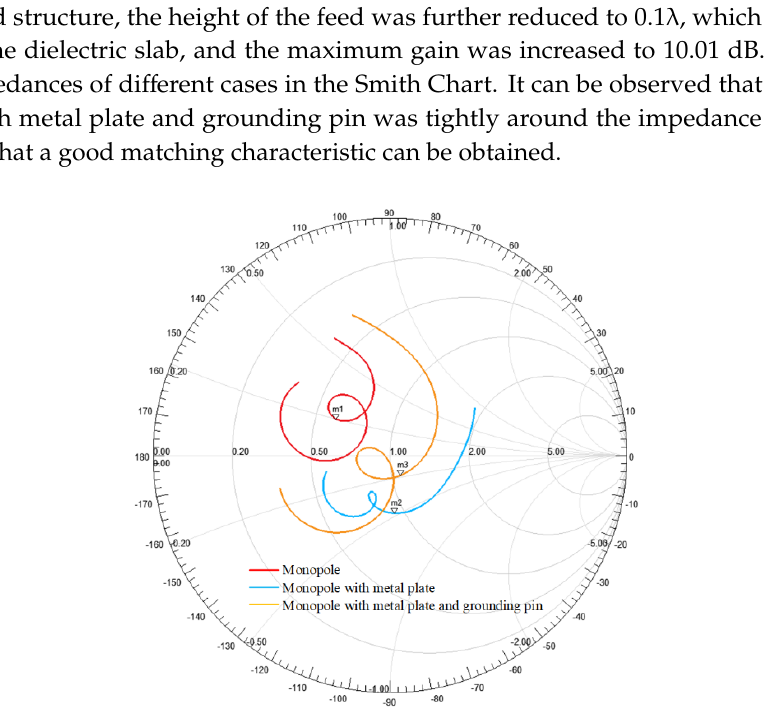
Figure 6. The input impedances of different feed structures in Smith Chart. The mark points, m1, m2, and m3, are at the center frequency of 6 GHz.